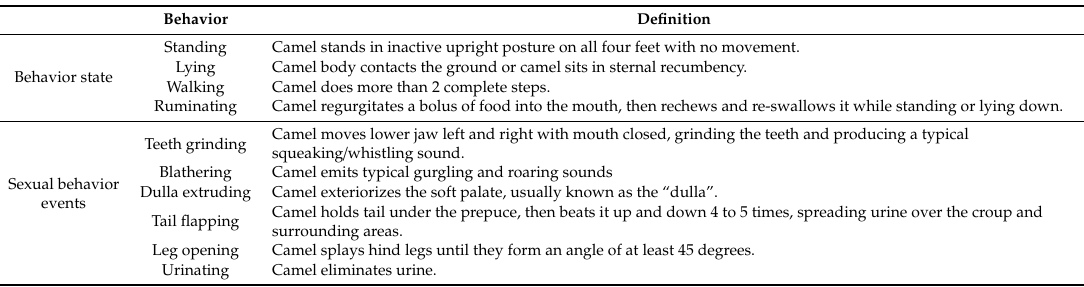
Table 1. Behavioral ethogram of